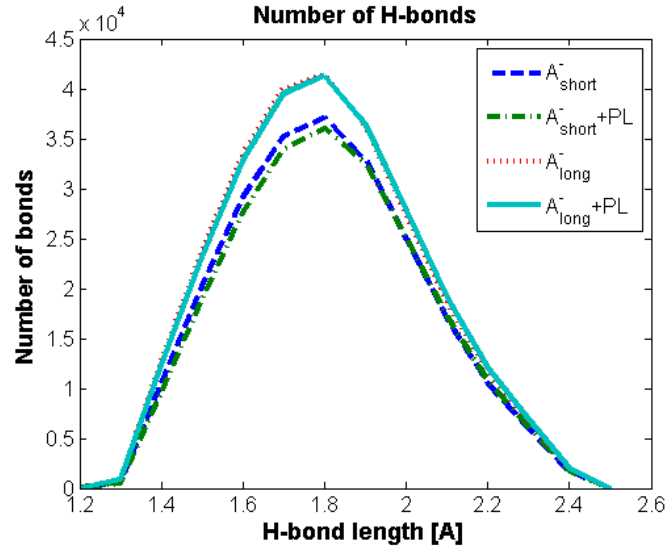
Figure 6. Total number of H-bonds between A- chains dependent on H-bond length.